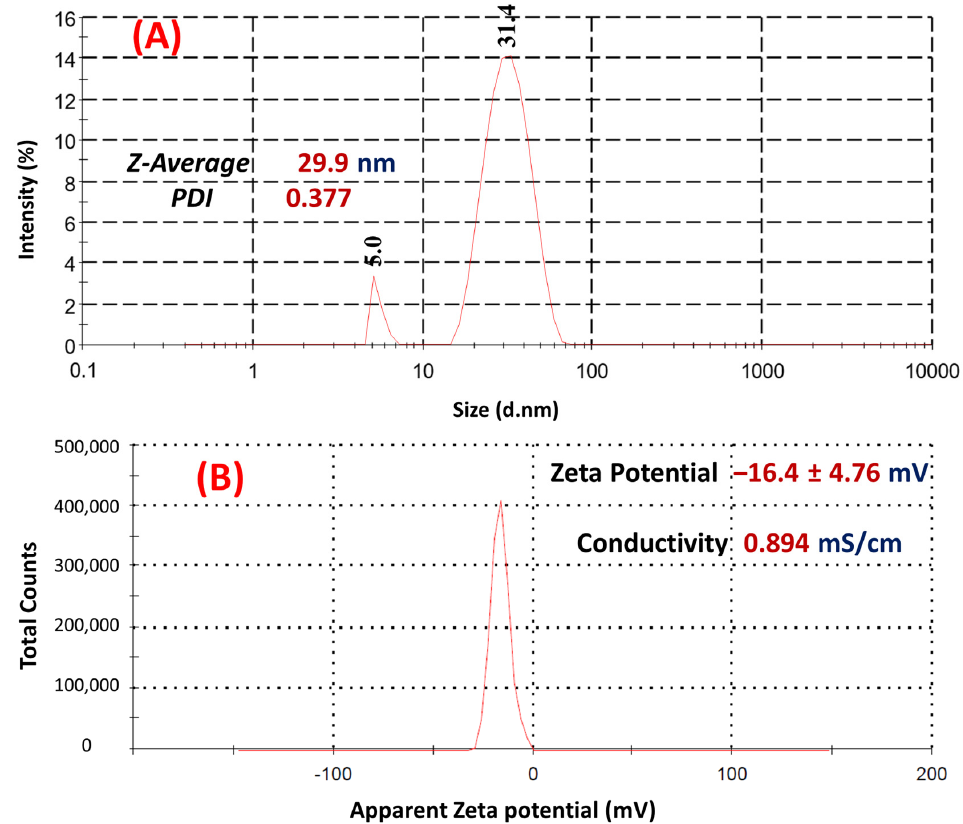
Figure 8. DLS ( A ) and Zeta potential ( B ) of GC-capped Ag NPs.